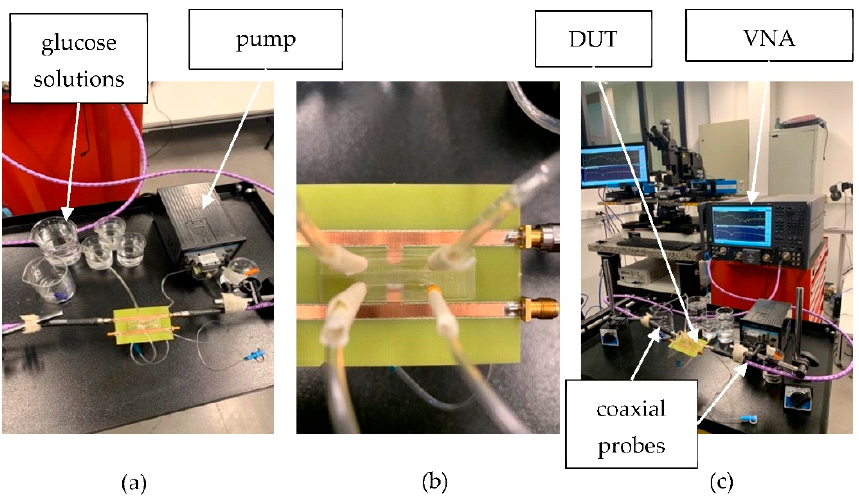
Figure 8. Photograph of ( a ) solutions and peristaltic pump, ( b ) assembled sensor, ( c ) experimental setup of the sensor with equipment.